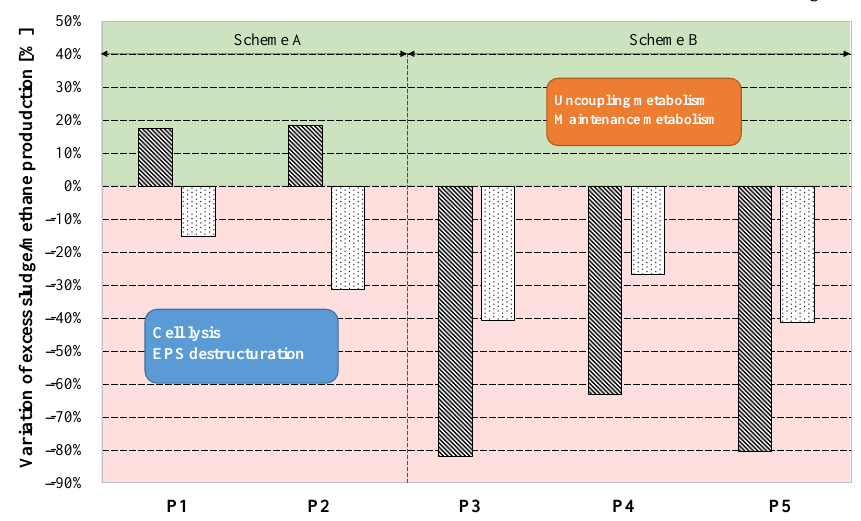
Figure 7. Overall effects of the OSA process on excess sludge minimization and methane productivity during the experiment.